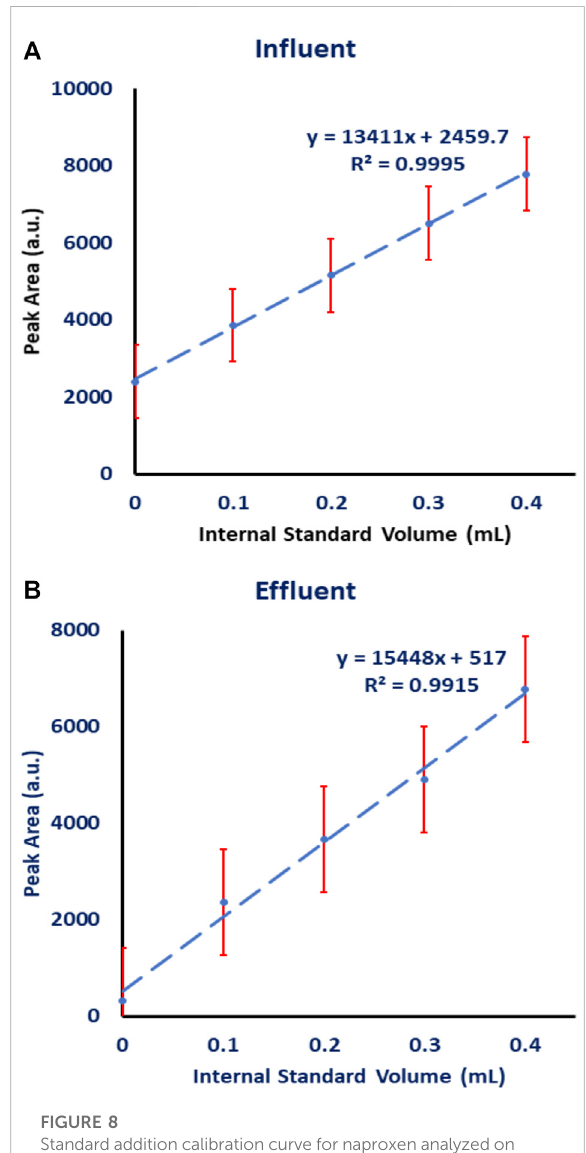
FIGURE 8 Standard addition calibration curve for naproxen analyzed on HPLC-FLD in the presence of CB7 added to the mobile phase. The unknown volume was 0.2 mL and the concentration of spiked naproxen standard was 100 ppb and its volume was 0.1 mL. (A) in fl uent wastewater, (B) ef fl uent wastewater.